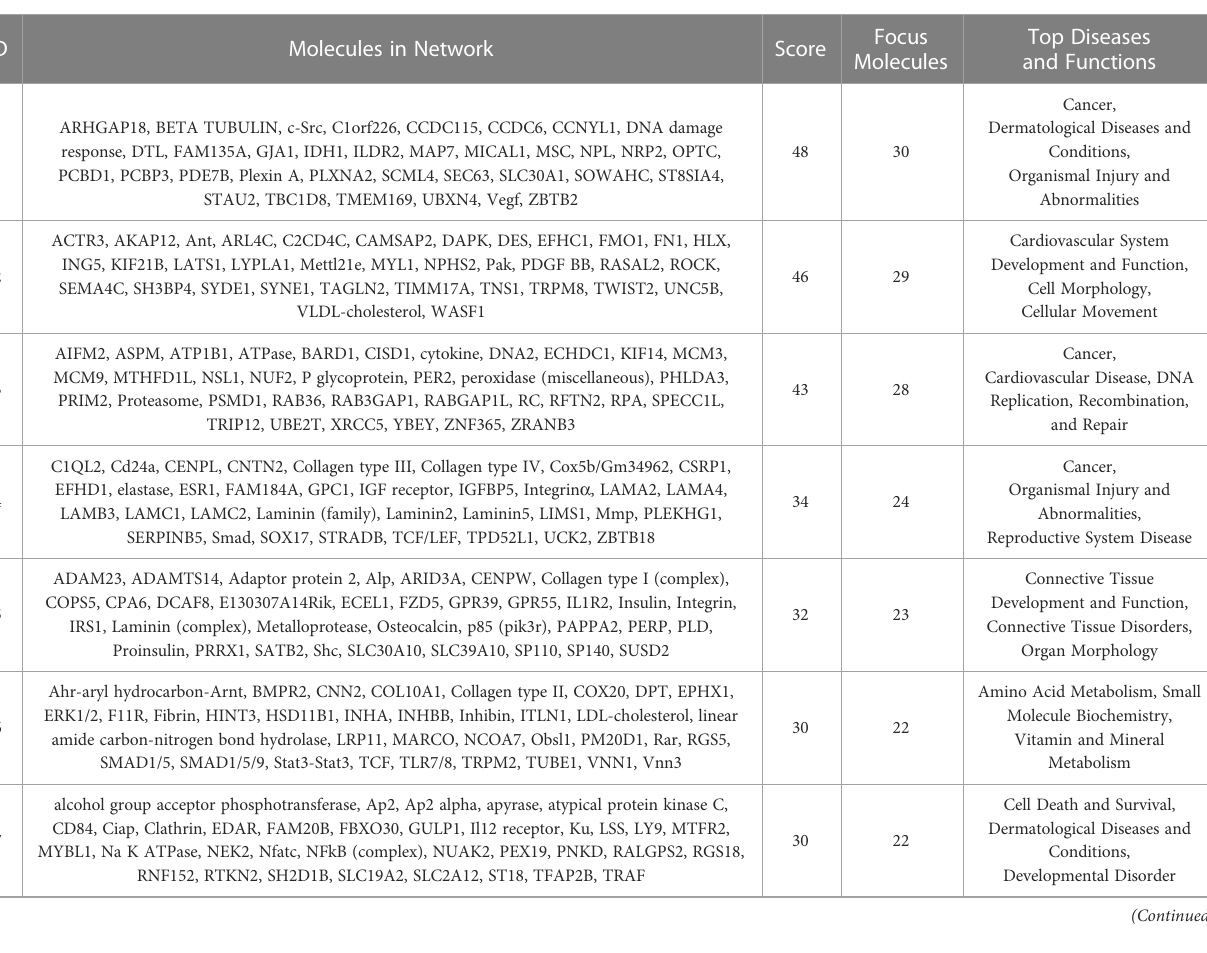
TABLE 3 A list of molecular networks of DEGs in CgP versus